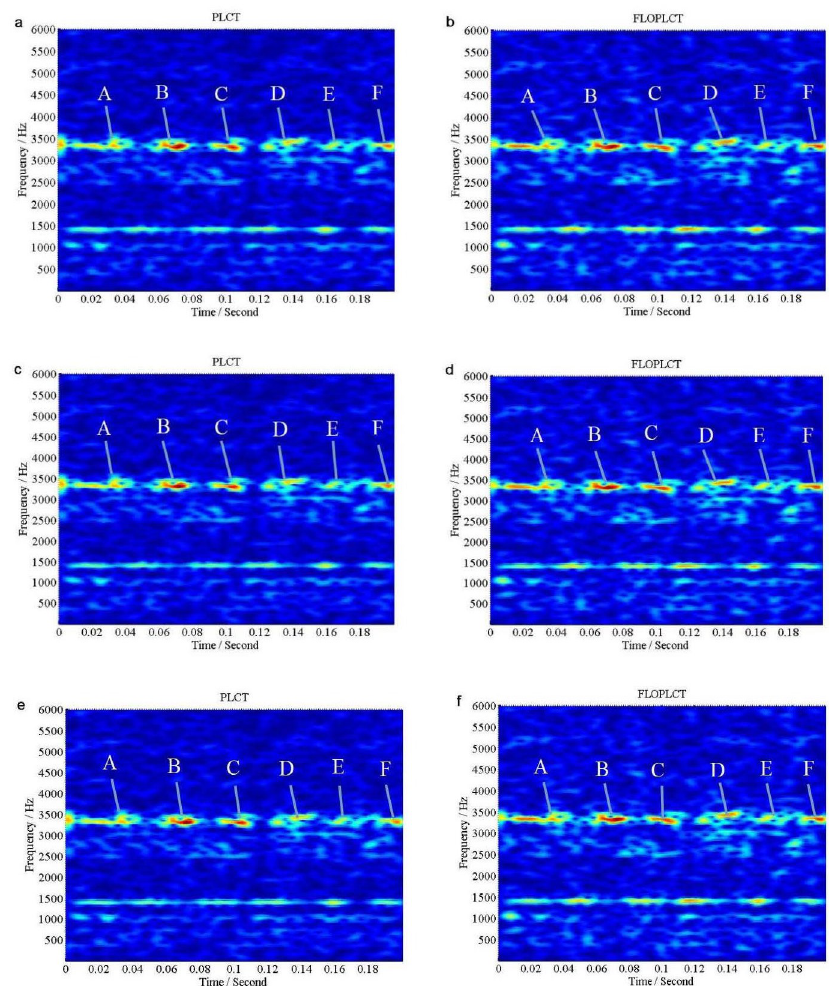
Fig 10. The time-frequency representations of the bearing ball fault in the position of DE data contaminated by Gaussian noise ( SNR = 5 dB ). (a. The first time PLCT time-frequency representation; b. The first time FLOPLCT time- frequency representation; c. The second time PLCT time-frequency representation; d. The second time FLOPLCT time-frequency representation; e. The third time PLCT time-frequency representation; f. The third time FLOPLCT time-frequency